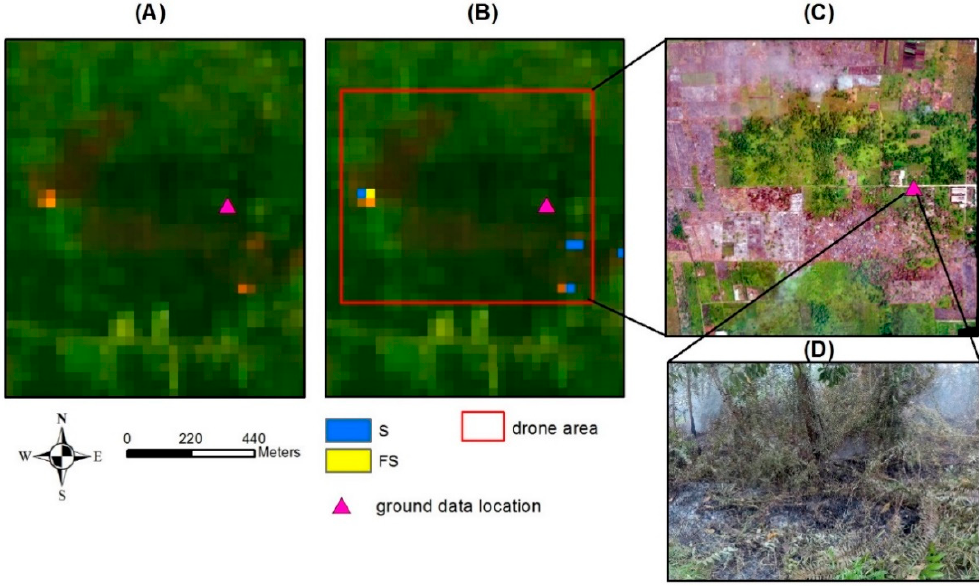
Figure 11. ( A ) The 764 RGB image of Landsat-8 on 5 October 2018, presented a combustion area which was predominantly vegetated, ( B ) The result of peatland combustion mapping, and ( C ) Drone imaging and ( D ) Terrestrial picture of smouldering vegetation area in the area on 6 October 2018.